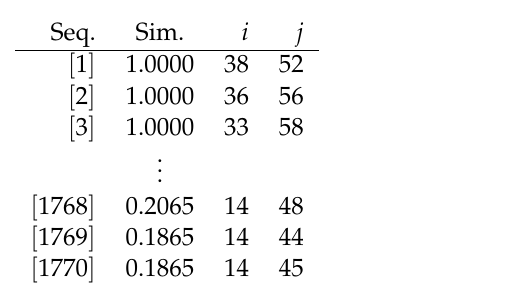
Figure 1. Sample data for demonstration.